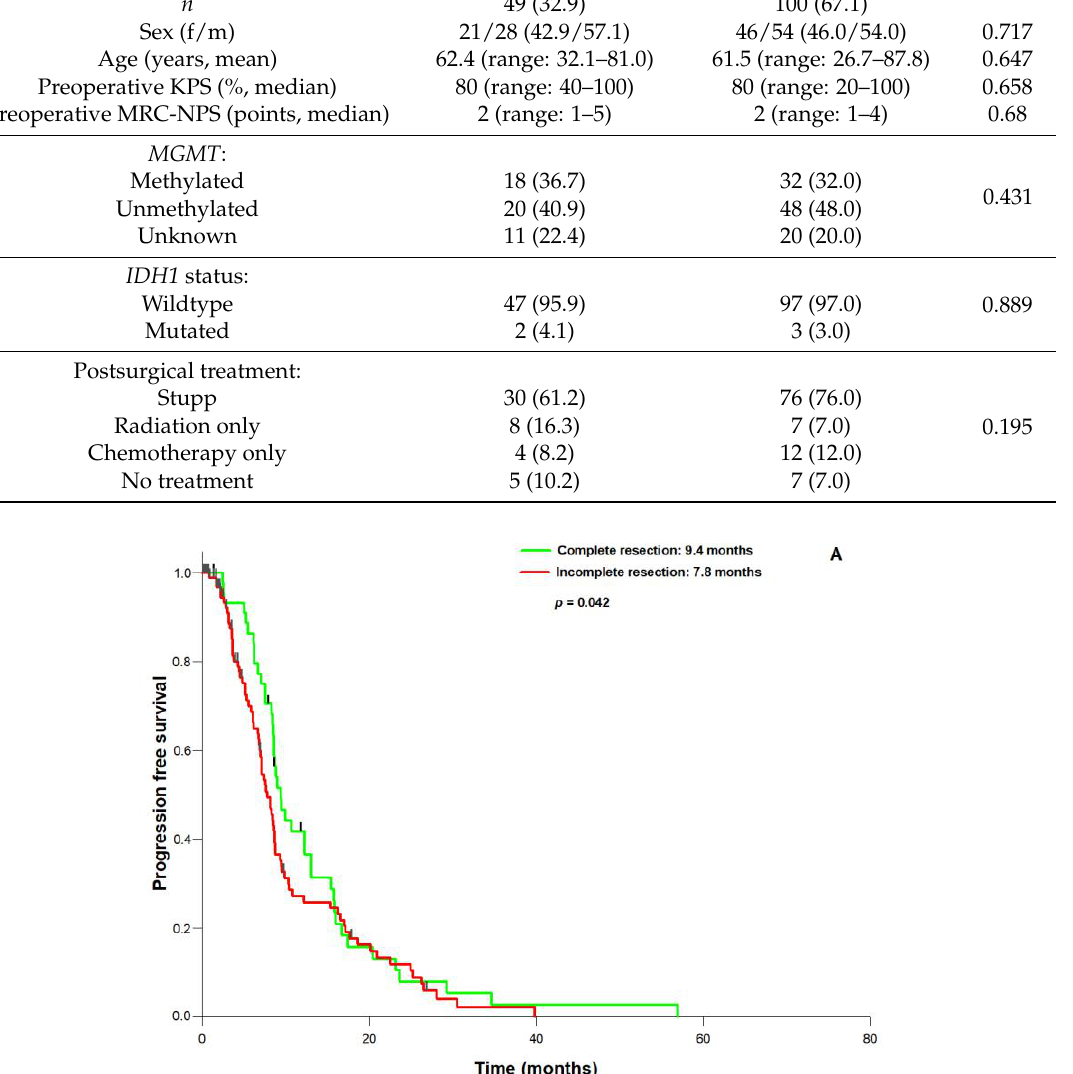
Table 4. Baseline characteristics of the two patient subcohorts. Group A: Subcohort of patients with newly diagnosed GBM treated before the foundation of a specialized neuro-oncology center (NOC). Group B: Subcohort of patients treated after the NOC foundation.